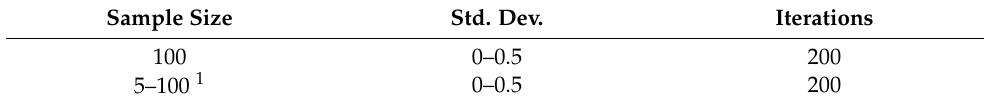
Table 3. Model parameters for theExample 2b.